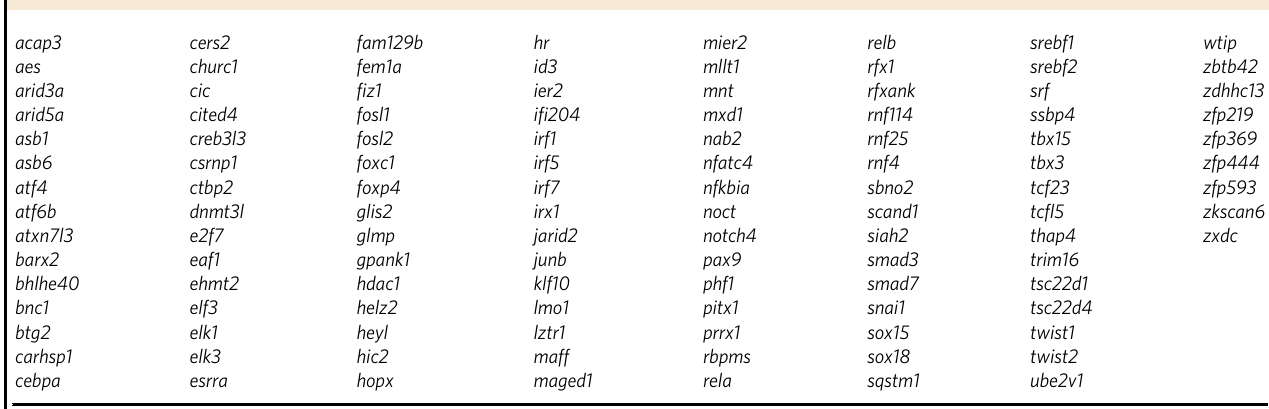
Based on p -value < 0.05.